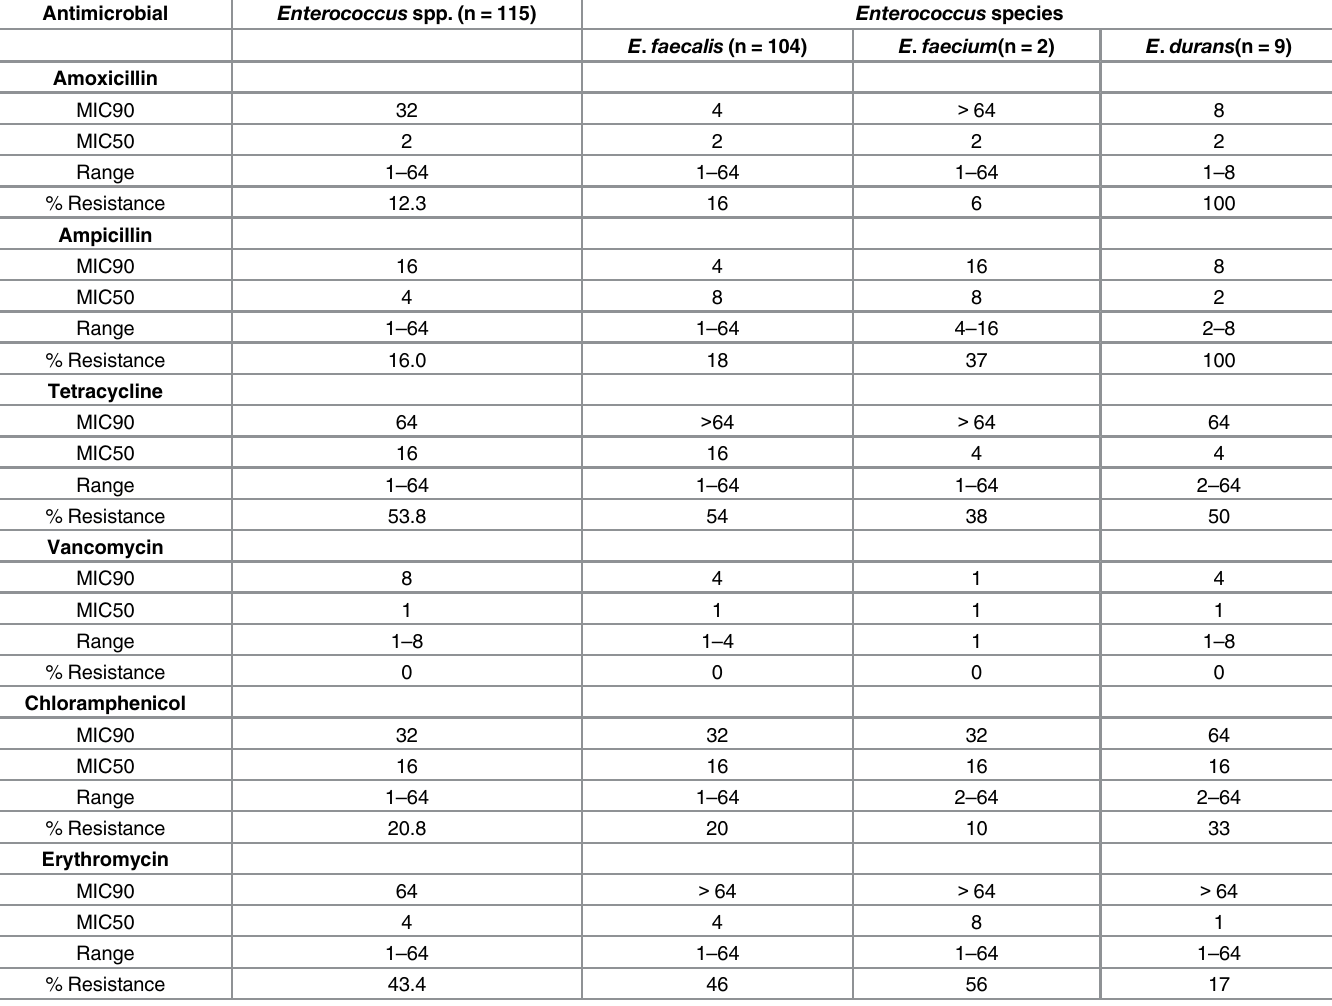
Table 4. Break point antimicrobial sensitivity profiles (values in μ g/ml) of oral E . faecalis , E . faecium and E . durans spp.